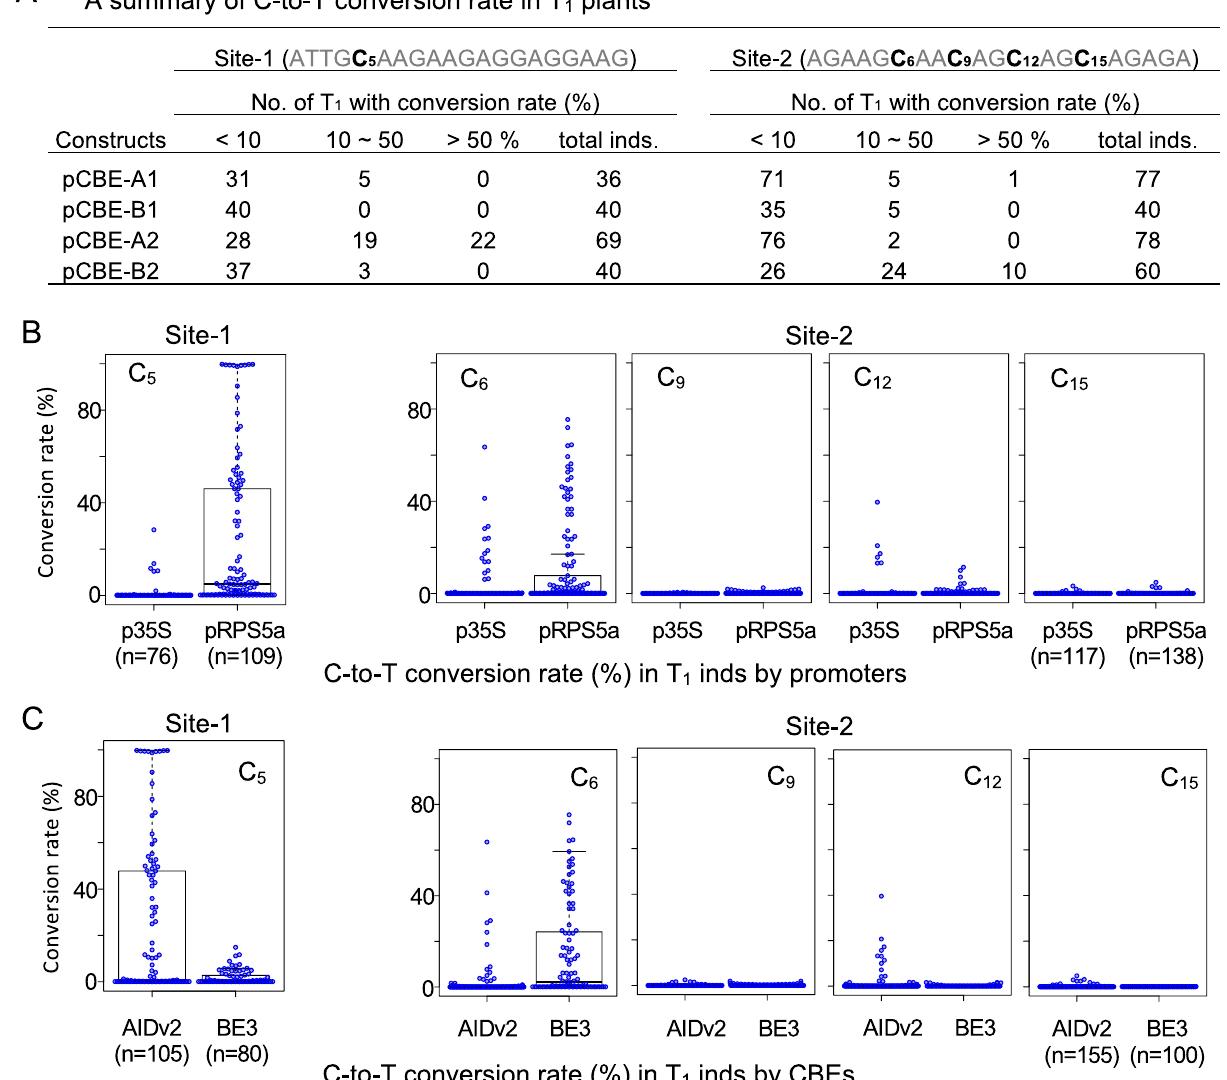
Figure 3. Comparison of the effects of different promoters and base editors on cytosine-to-thymine conversion rates in the first generation of transformed Arabidopsis individuals (T 1 ). ( A ) C-to-T conversion rates calculated from targeted deep sequencing analysis of each T 1 individual are presented. The numbers of individuals with low (< 10%), middle (10–50%), or high (> 50%) conversion rates are indicated. ( B , C ) Comparison of base editing efficiencies with different combinations of promoter and cytosine base editor (CBE) in vector constructs. All C-to-T conversion rates from T 1 individual plants were grouped by vector and the construct used and plotted. ( B ) Comparison of conversion rates grouped by promoter set: CaMV35S versus RPS5a (pCBE-A1 and pCBE-B1) versus (pCBE-A2 and pCBE-B2). ( C ) Comparison of conversion rates grouped by CBE set: AIDv2 versus BE3 (pCBE-A1 and pCBE-A2) versus (pCBE-B1 and pCBE-B2). Each open dot represents the C-to-T conversion rate for each T 1 individual. C-to-T conversion rates were calculated for each targeting cytosine position. Inds